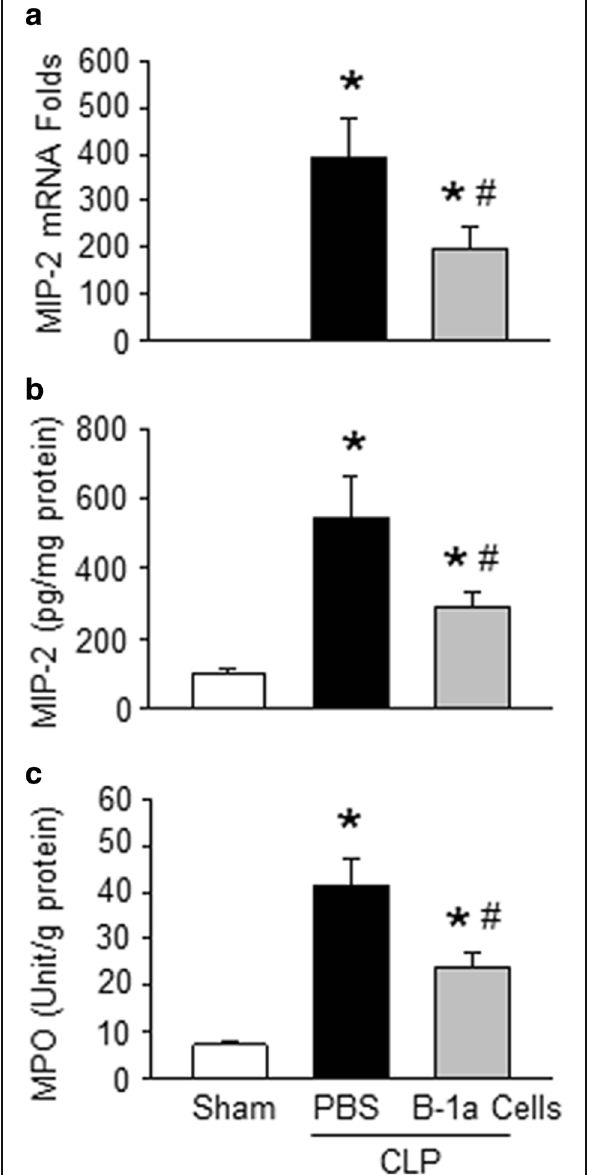
Fig. 3 B-1a cells attenuate MIP-2 and MPO levels in lungs after sepsis. a , b At the time of CLP, mice were treated with either PBS as vehicle or 5×10 5 PerC B-1a cells in 150 μ l of PBS by i.p. injection. After 20 h, lung tissue was harvested and mRNA and protein expression of MIP-2 were assessed, respectively. c MPO activity in lungs of sham-operated, and PBS or B-1a cell-treated CLP mice was determined. Data are expressed as means±SE ( n =9 mice/group from 3